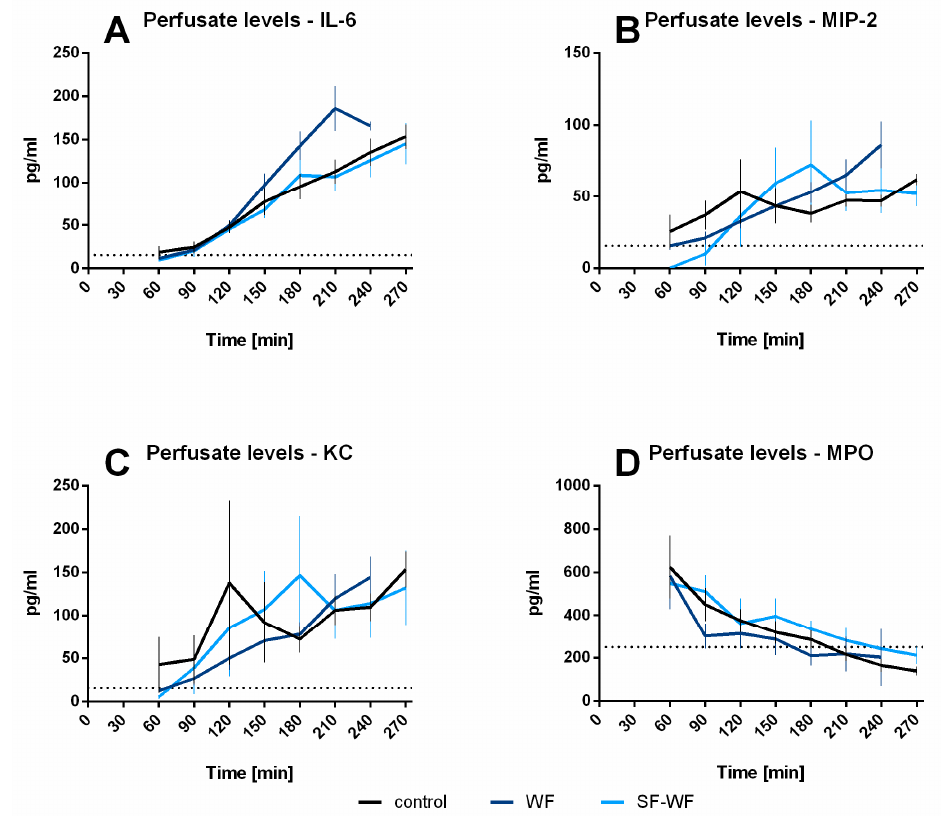
Figure 4. Influence of welding fume instillation: Cytokine release of isolated perfused lungs into perfusate. ( A ): IL-6 levels in perfusate (mean ± SEM), ( B ): KC levels in perfusate (mean ± SEM), ( C ): MIP-2 levels in perfusate (mean ± SEM), ( D ): MPO levels in perfusate (mean ± SEM), control and WF n = 6, SF-WF n = 5.